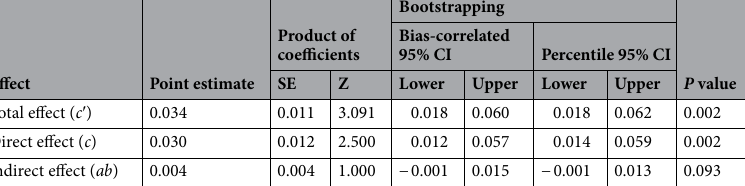
Table 4. Total, direct and indirect effects of the median model that Lp(a) has effect on AA-induced AAR through Lp-PLA2. c ′ total path of the whole model, c direct effect of Lp(a) on AA-induced-AAR, ab product of coefficients, Lp ( a ) lipoprotein a, AA arachidonic acid, AAR average aggregation rate, Lp-PLA2 lipoprotein- associated phospholipase